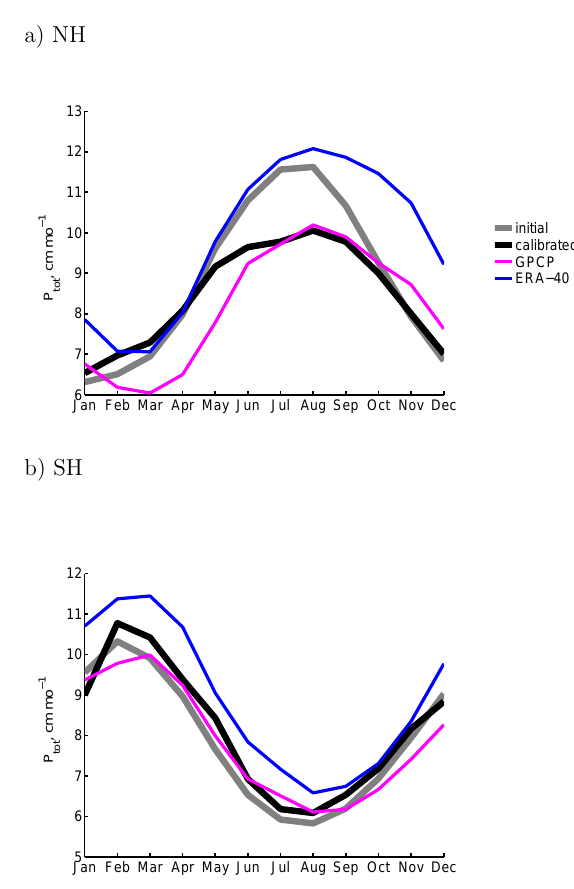
Fig. 10. Total precipitation (cmmo − 1 ) averaged over the Northern and Southern Hemisphere ( a and b respectively) for the model with standard and calibrated parameter sets (grey and black lines respec- tively) as well as for the GPCP and ERA-40 data sets (magenta and blue curves